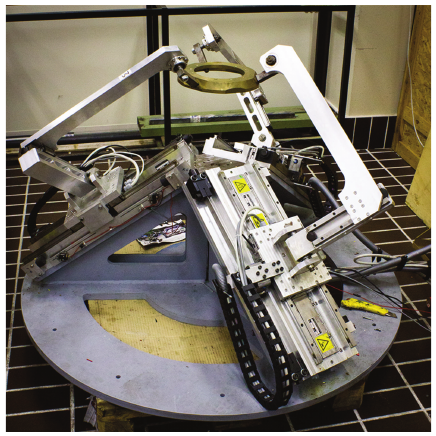
Figure 10: The prototype of the spherical parallel